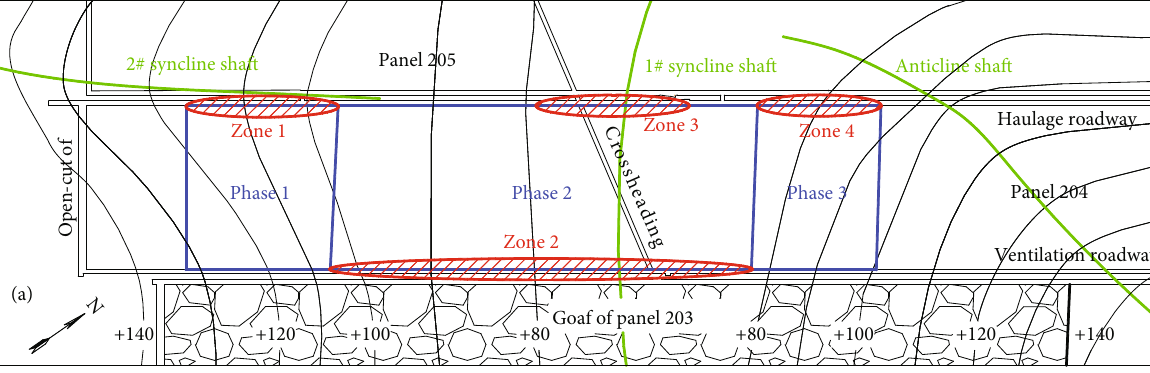
Figure 8: Burst risk zoning features of panel 204 and the fi lled ellipses indicate high burst risk zones.